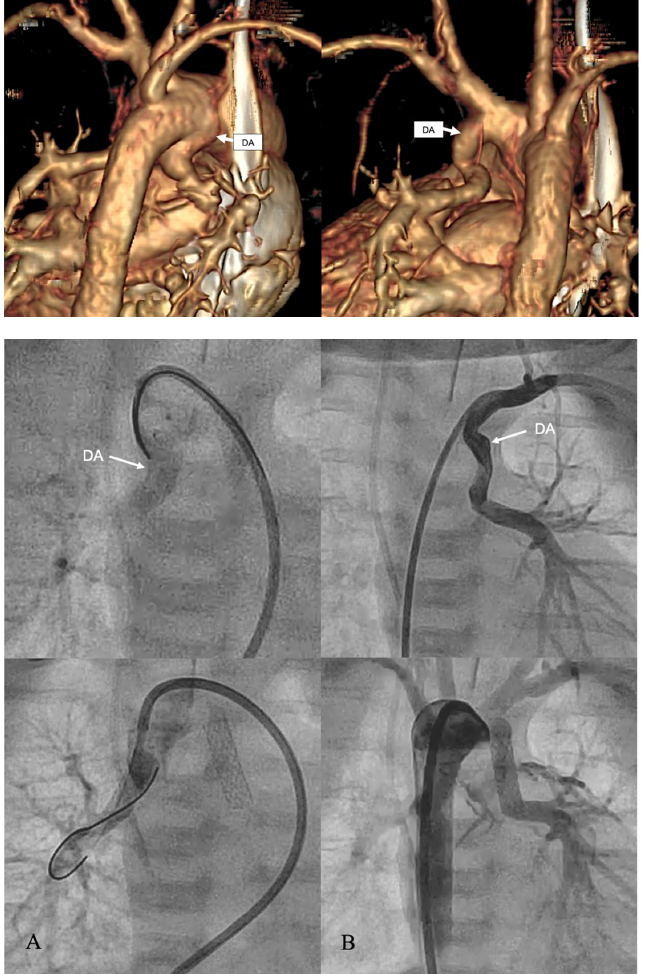
Figure 7. Three-dimensional volume rendering of the computed cardiac tomography (CCT) demonstrated right aortic arch with bilateral ductus arteriosus (DA). One is from the aortic arch to supply the right PA, another one is from the innominate artery to the left lung. Both DAs were successfully stented. ( A , B ).